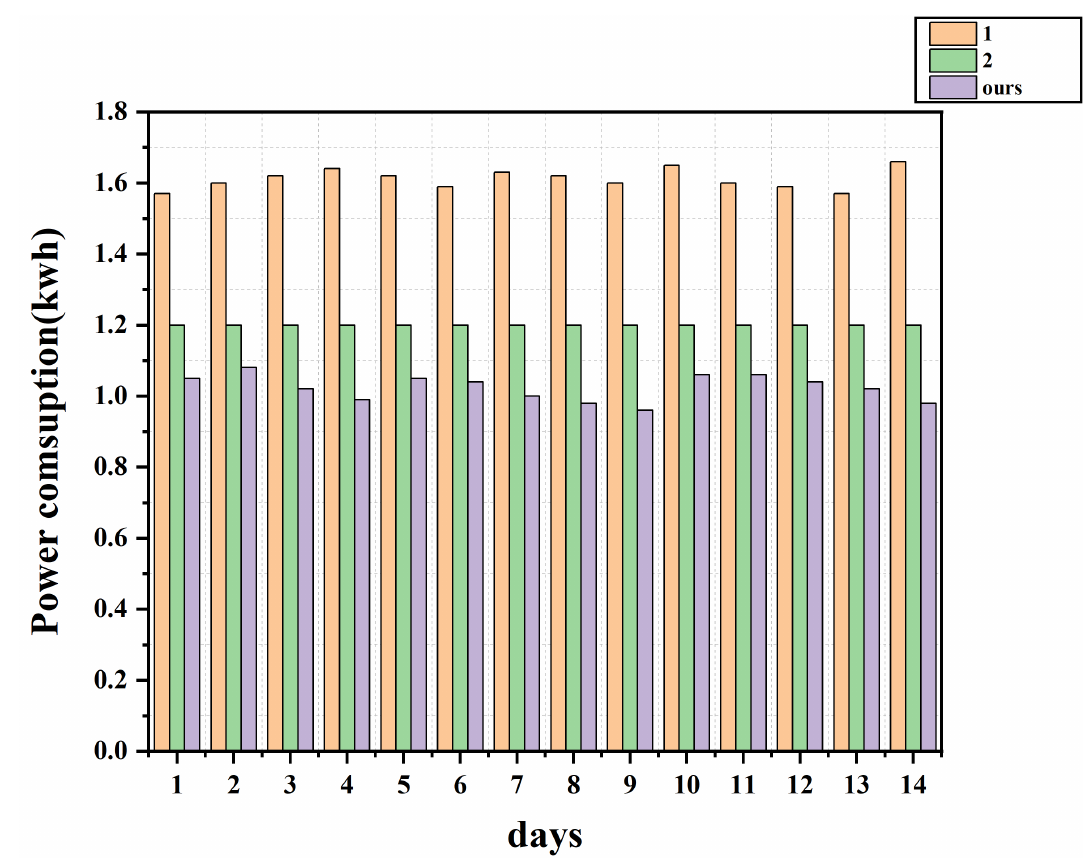
Figure 14. Comparison of power consumption of three